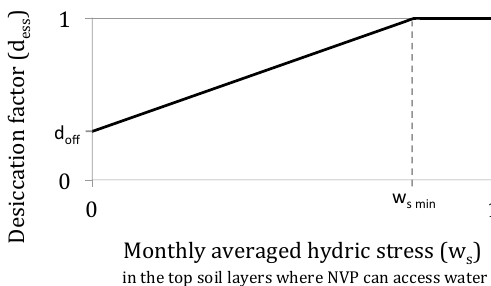
Figure 3. Desiccation function for Non-Vascular